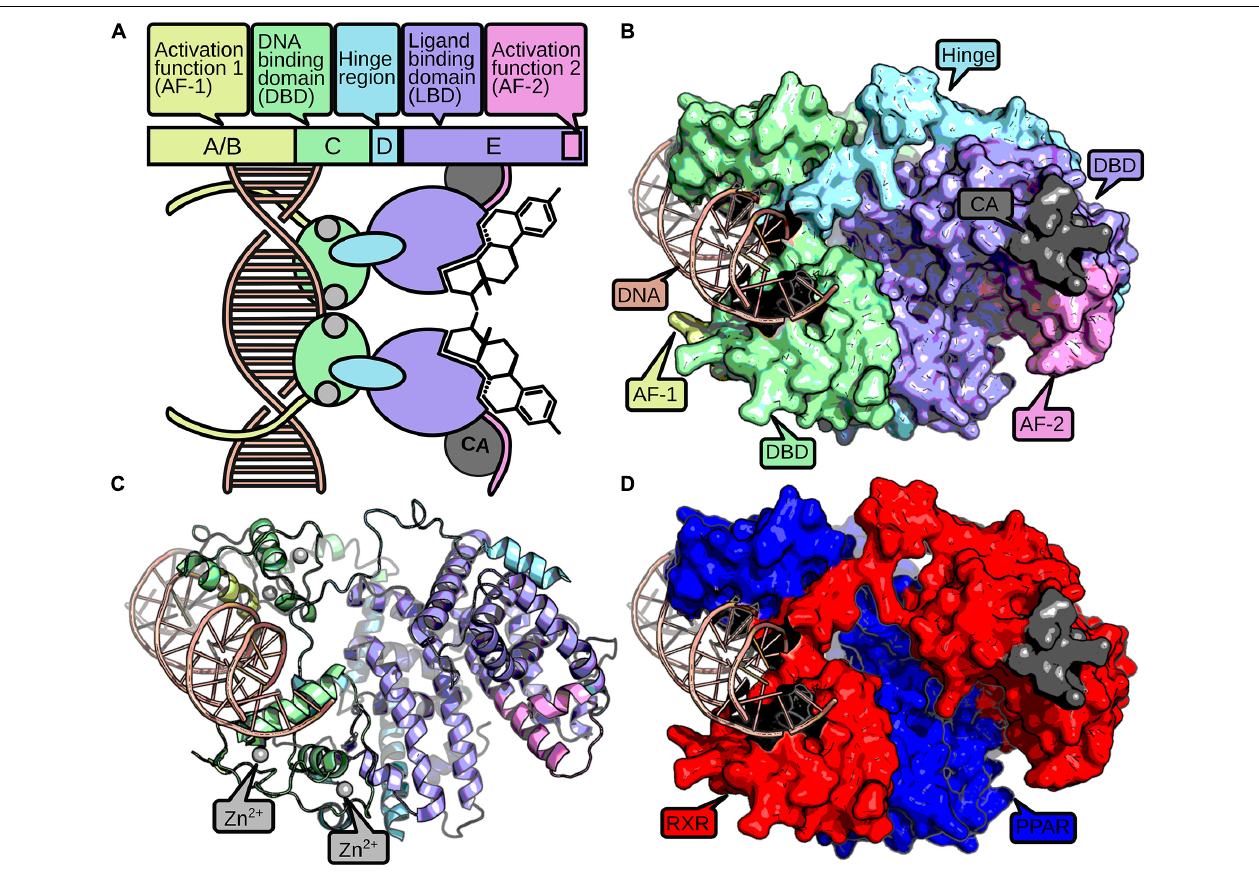
FIGURE 1 | The structure of a nuclear receptor is defined by up to five domains. The AF-1 domain (yellow) can mediate ligand-independent transcriptional regulation. The DBD consists of two zinc-finger domains (green), which are stabilized by zinc ions (gray). The zinc-finger domains recognize and bind to specific DNA-binding sites (red). A hinge region (blue) connects the DBD and the LBD (purple). The LBD usually binds a small hydrophobic ligand, which induces dimerization and a conformational change in the AF-2 domain (pink). Active AF-2 stabilizes the binding to the DNA by recruiting coactivators (CA, dark gray) and mediates transcriptional activity. A schematic representation of a NR homodimer is displayed in (A) , while a surface and cartoon representation of an RXR-PPAR heterodimer crystallization (PDB: 3DZY) (Chandra et al., 2008) is given in (B,C) , respectively, following the same color scheme as above. For better discrimination of the two dimers, (D) displays PPAR in blue and RXR in